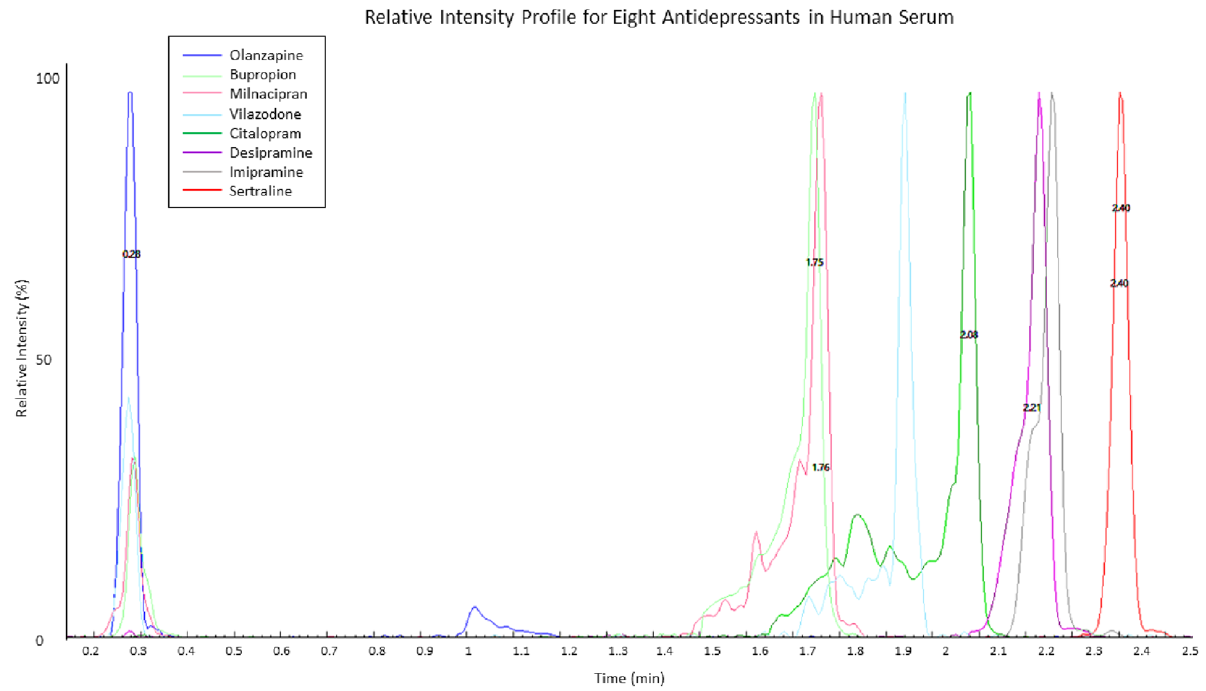
Figure 2. Chromatograms showing the retention times (RT) of each analyte studied (in serum) and their relative intensity